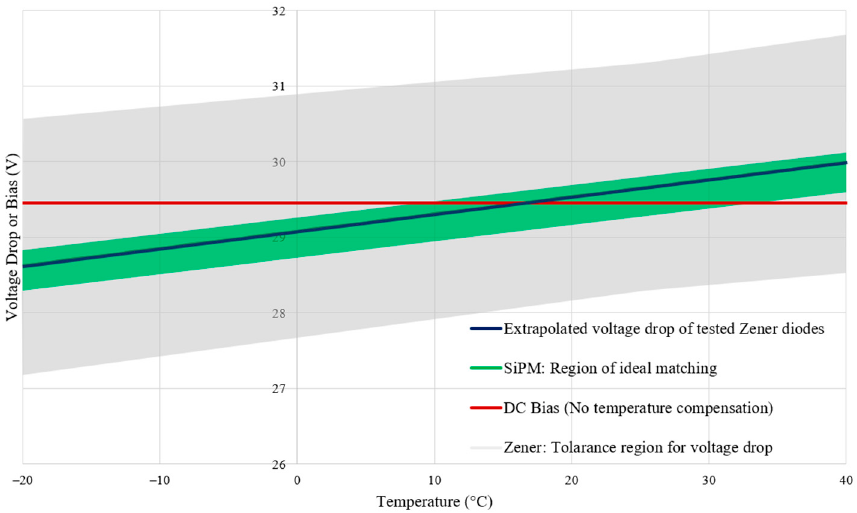
Figure 8. Combined plot of the extrapolated voltage drop caused by the measured Zener diodes compared with a set DC bias, ideal voltage drop region for biasing the SiPM, and the region of tolerance given to the Zener diode’s voltage drop by the manufacturer.